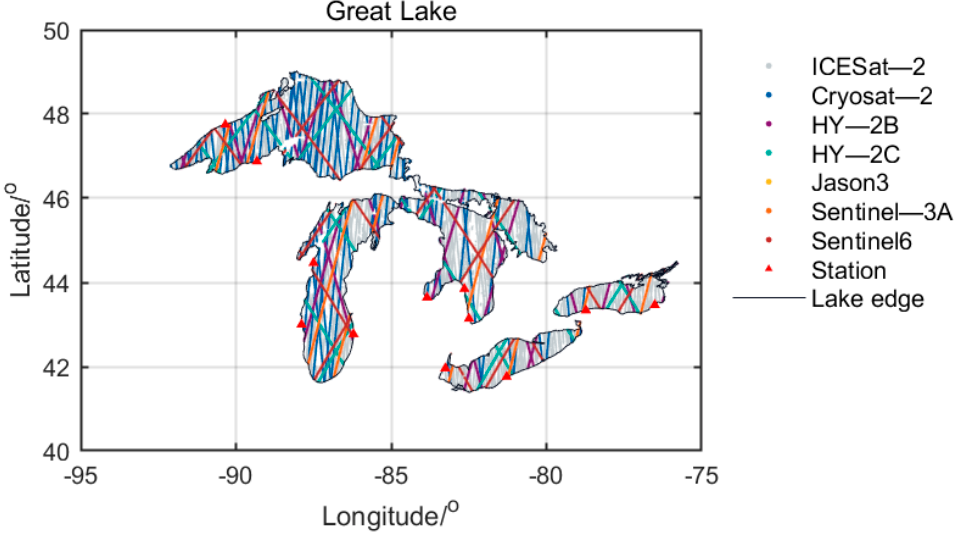
Figure 2. Satellite track distribution map.